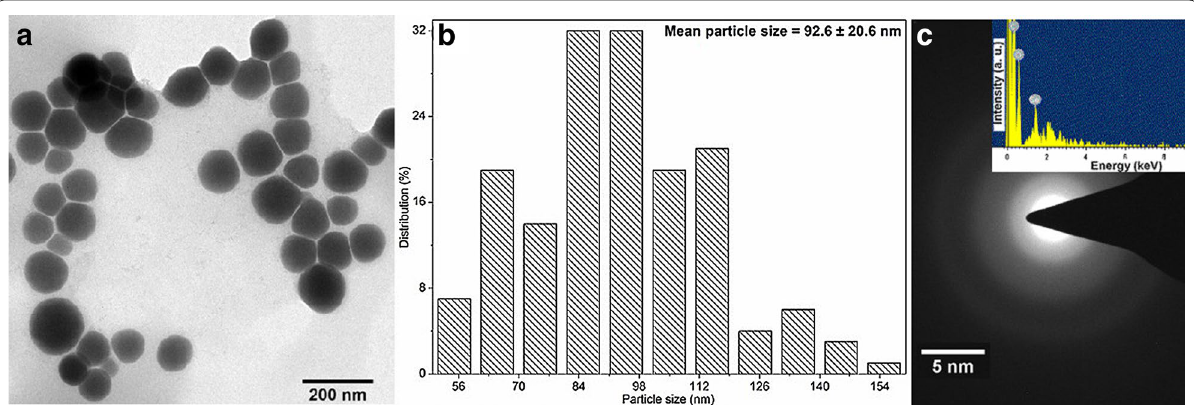
Fig. 6 a TEM image of selenium nanoparticles synthesized with 1 mM selenite at 72 h, b histogram showing the particle size distribution, and c corresponding SAED pattern